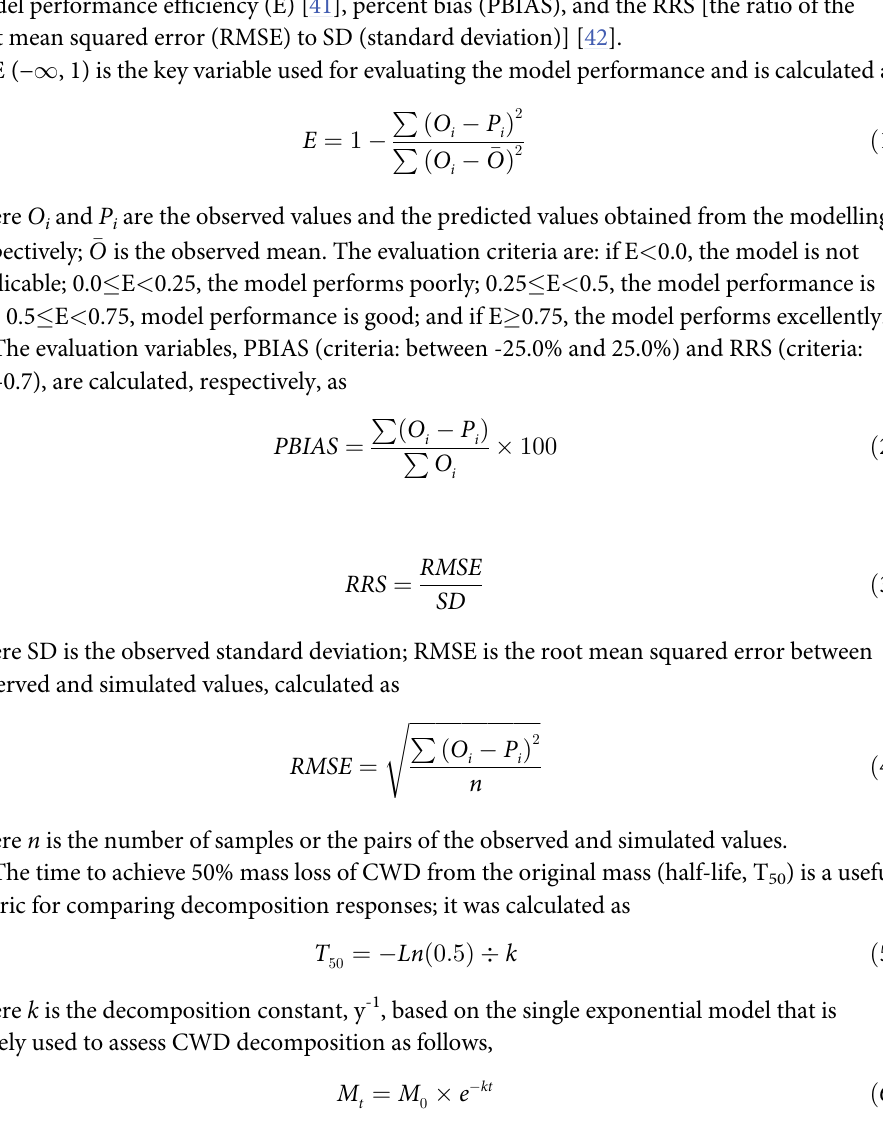
model performance efficiency (E) [41], percent bias (PBIAS), and the RRS [the ratio of the root mean squared error (RMSE) to SD (standard deviation)] [42]. E ( − 1 , 1) is the key variable used for evaluating the model performance and is calculated as E ¼ 1 (cid:0)